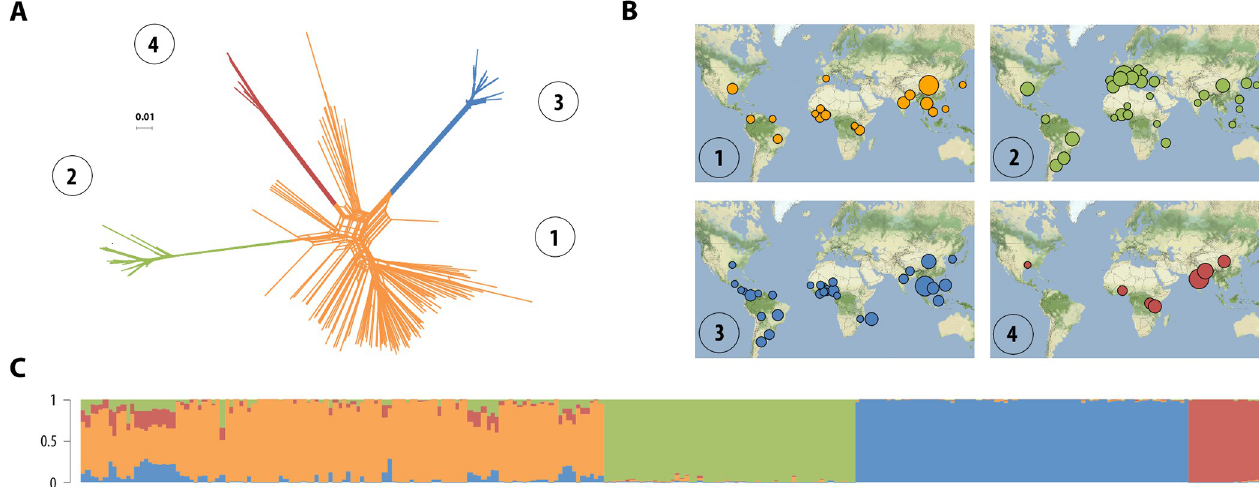
Fig 1. Rice-infecting P . oryzae populations are divided into four major lineages. Population subdivision was inferred from 264 distinct P . oryzae genotypes, representing 886 isolates, and the four lineages were represented in different colors. (A) Neighbor-net phylogenetic network estimated with S PLITSTREE ; reticulations indicate phylogenetic conflicts caused by homoplasy. (B) Geographic distribution of the four lineages identified with S PLITSTREE (A) and S NMF (C), with disk area proportional to sample size. (C) Ancestry proportions in K = 4 clusters, as estimated with S NMF software; each multilocus genotype is represented by a vertical bar divided into four segments indicating individual ancestry coefficients in K = 4 clusters. Map tiles by Stamen Design, under CC BY 3.0, and data by OpenStreetMap, under ODbL (http://maps.stamen.com/#terrain/).